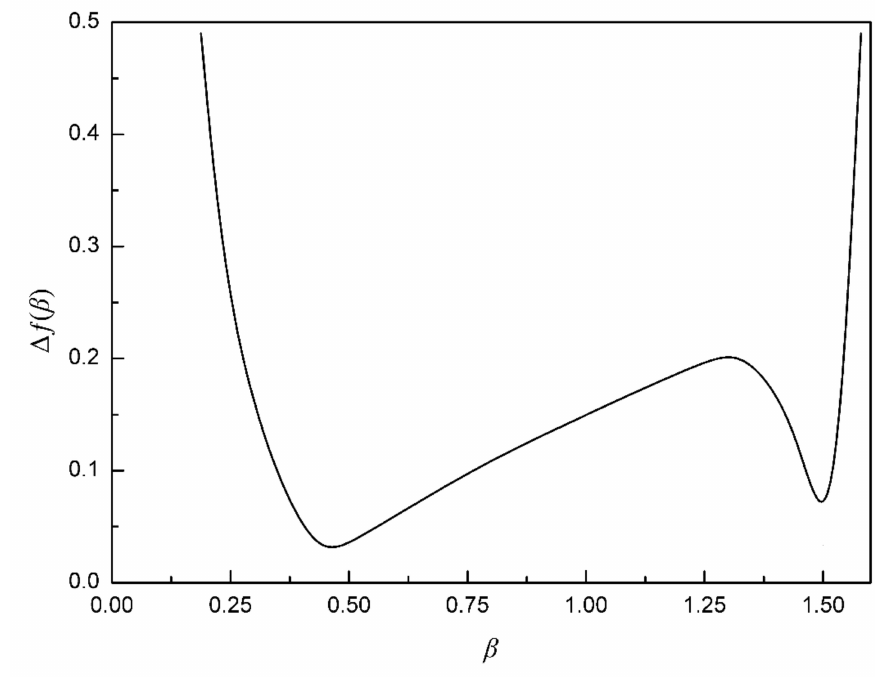
Figure 7. Graph of residual function (cid:52) f ( β ).